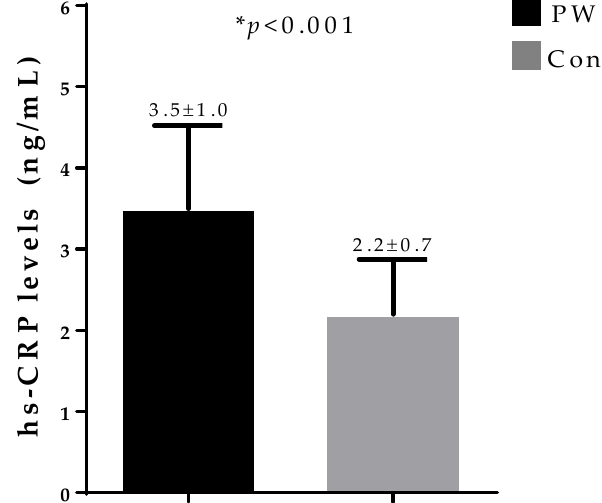
Figure 2. Di ff erence in hs-CRP levels in PWS adults and control group. PWS adults presented higher hs-CRP levels compared with non-PWS adult counterparts ( p < 0.001). PWS, Prader–Willi syndrome; hs-CRP, high-sensitivity C-reactive protein. * A p value < 0.05 means a significant di ff